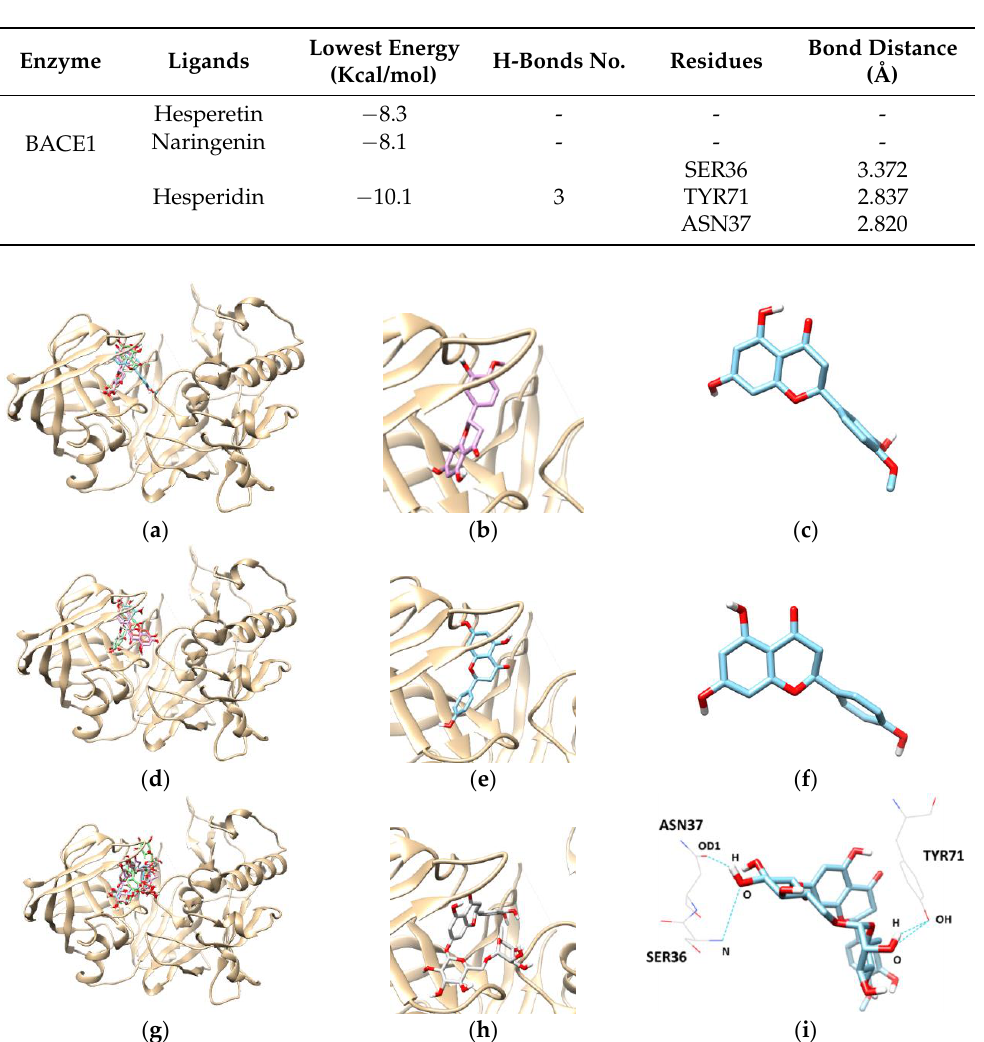
Table 3. Lowest energies and the number of hydrogen bond interactions of citrus flavanones in BACE1.